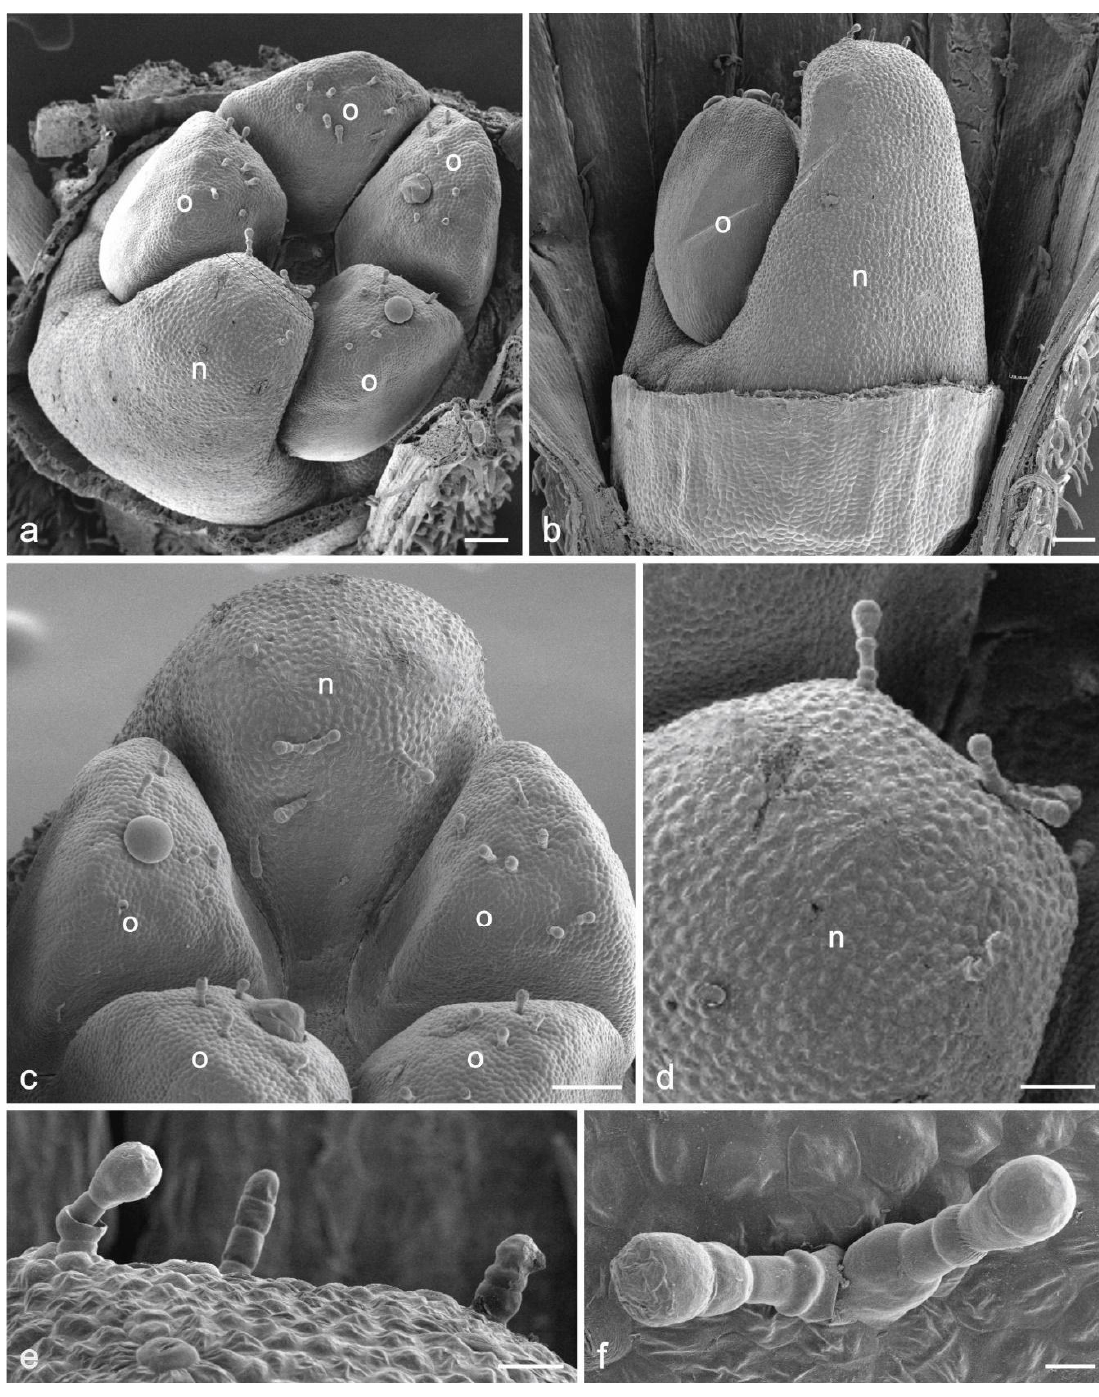
Figure 2. Scanning electron microscopy (SEM) micrographs of Dracocephalum moldavica floral nectary and ovary. ( a ) Ovary with the nectary in top view; ( b ) Abaxial surface of the longer nectary lobe and ovary part; ( c ) Different glandular trichomes on the top of the longer nectary lobe and on the ovary parts; ( d ) Upper part of the longer nectary lobe with glandular trichomes; ( e , f ) Trichomes on the nectary surface; o—ovary, n—nectary. Scale bars: 100 μ m ( a – c ), 50 μ m ( d ), 20 μ m ( e ), 10 μ m ( f ). During the flower development, the longer and shorter diameters of the nectary increased by over 20%, whereas the height of the longer lobe increased by 8% (Table 1). The nectary was light yellow in the closed bud stage (Figure 1h,i) and intensely yellow in the open flower stage (Figure 1j), which clearly distinguished it from the green ovary.